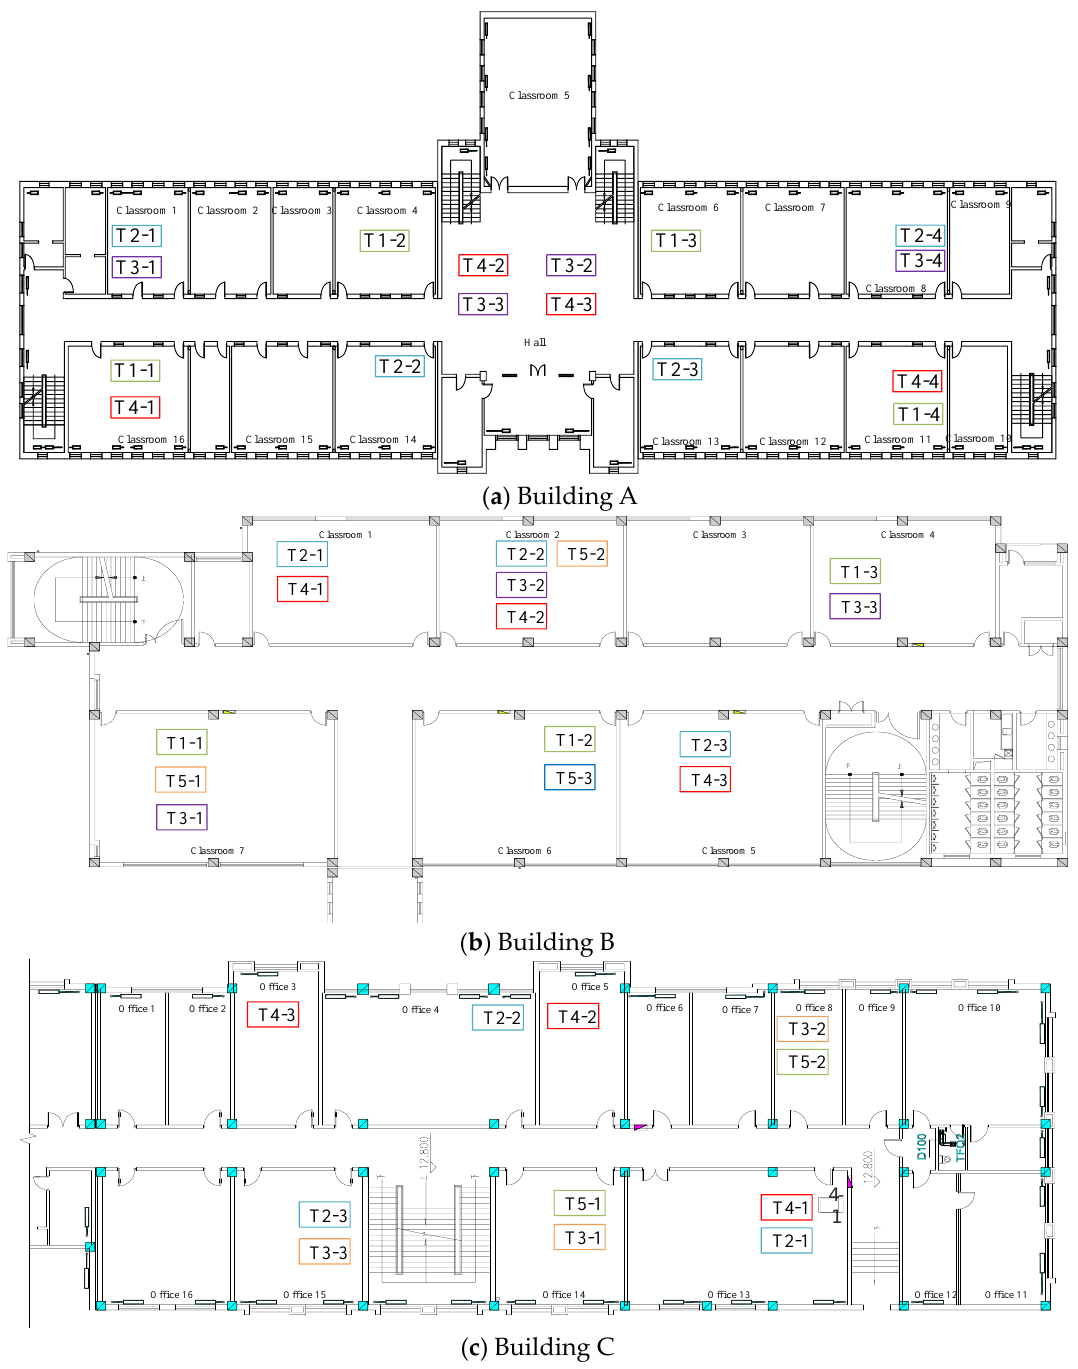
Figure 7. The layout of the indoor temperature measuring points.